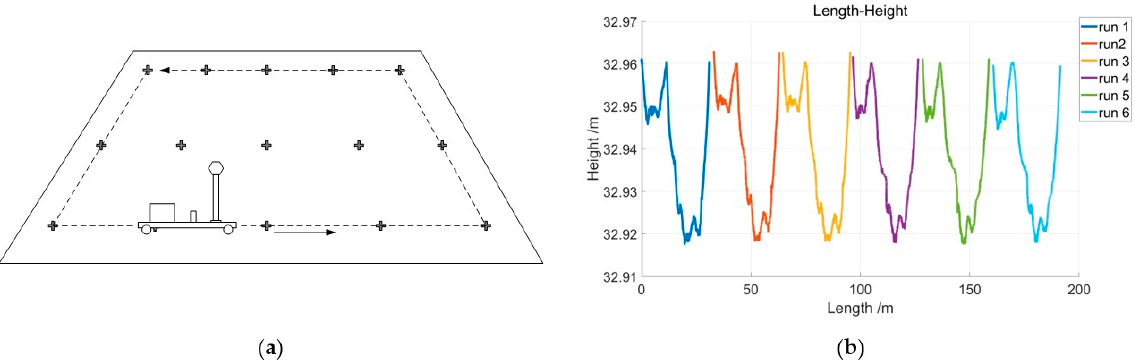
Figure 7. Repeatability of relative height measurement. ( a ) path of wheeled robot. ( b ) results of six